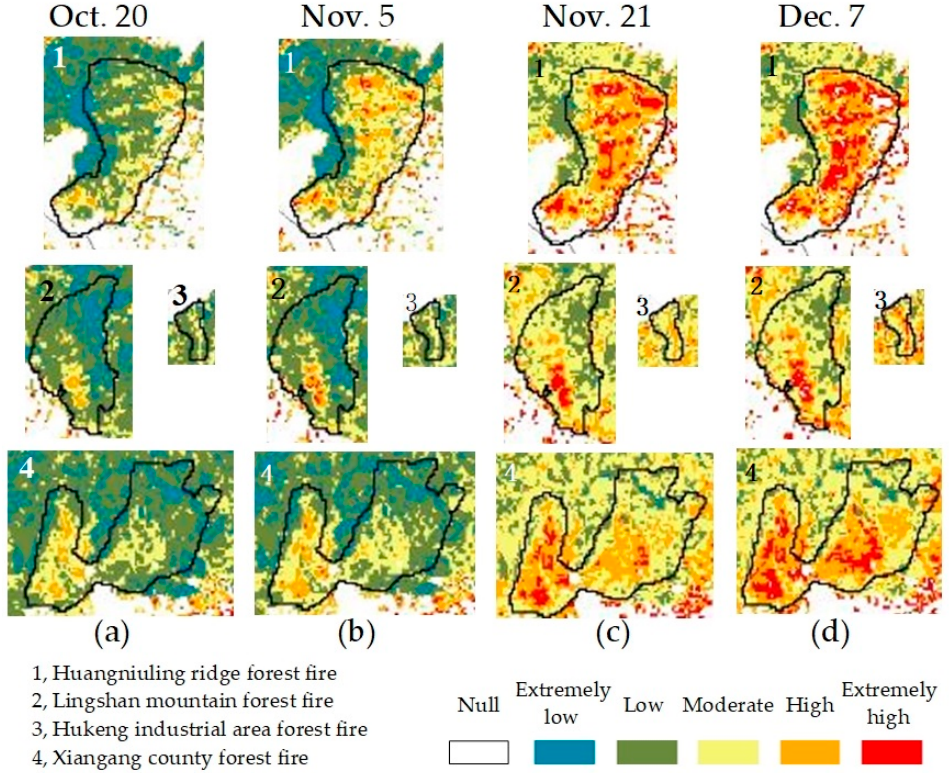
Figure 5. The spatial and temporal variations of forest fire risk in the ranges of the four fire events (zoom in the Figure 4). 20 October ( a ), 5 November ( b ), 21 November ( c ) and 7 December ( d ), 2019.